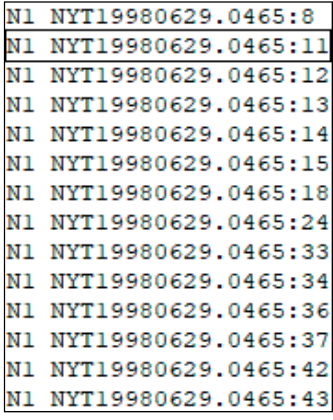
Figure 3. An excerpt in the dataset that contains a list of relevant sentences.